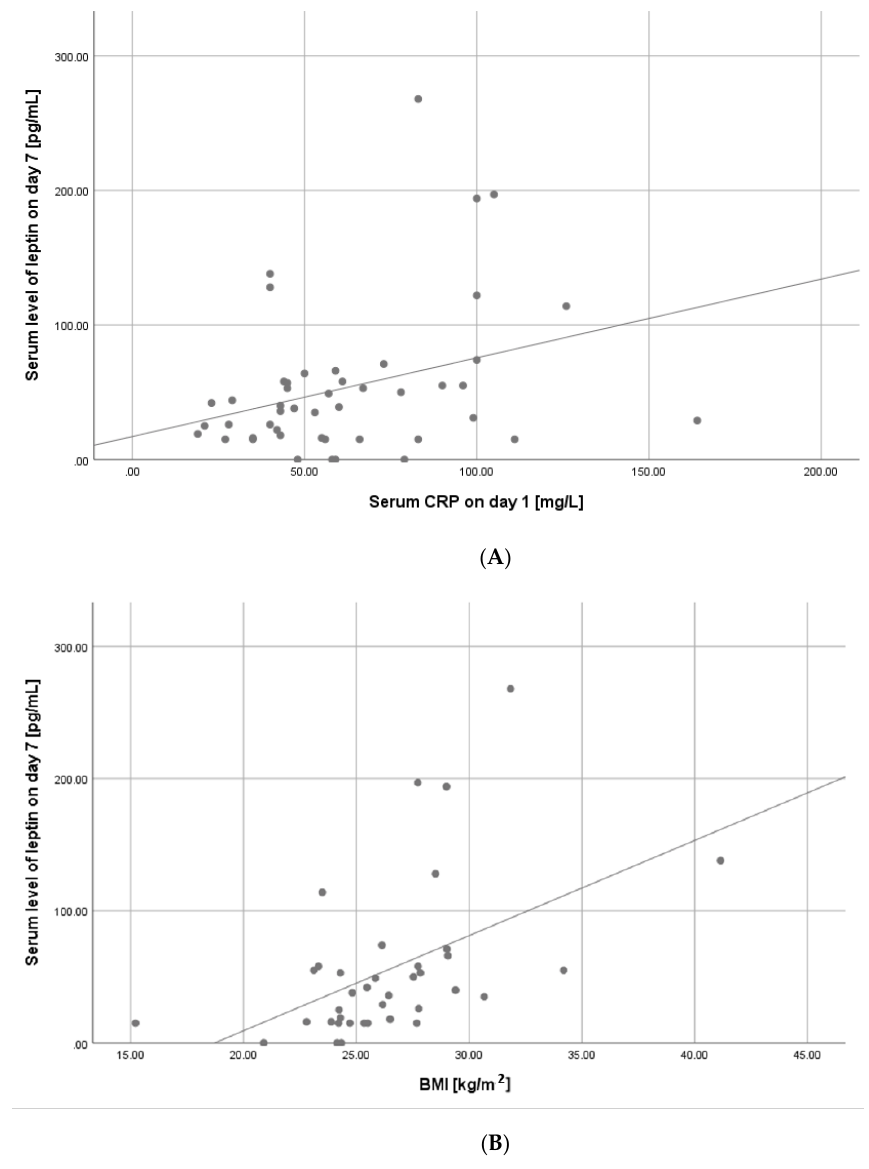
Figure 3. ( A ) Correlation between serum level of leptin on day seven and CRP levels on day one. R 2 R 2 = 0.104; ( B ) Correlation between serum level of leptin on day seven and = 0.104; ( B ) Correlation between serum level of leptin on day seven and BMI.